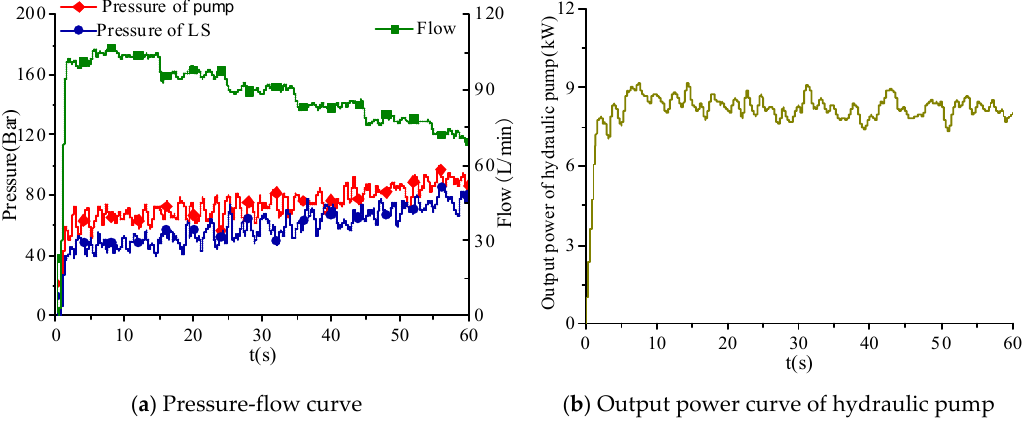
Figure 11. Test curve at 10% SOC.